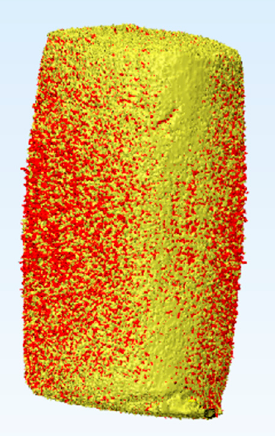
Figure 1. Superimposition of 3D objects created by growing a threshold region on the entire stack of scans of Filtek Bulk Fill resin composite specimen (5 mm) before curing (yellow) and after 20 s curing (red). The 3D properties of the object provided information about the volume of the specimen in µm 3 . By comparing the volume before and after curing, the percentage of the polymerization shrinkage could be calculated.